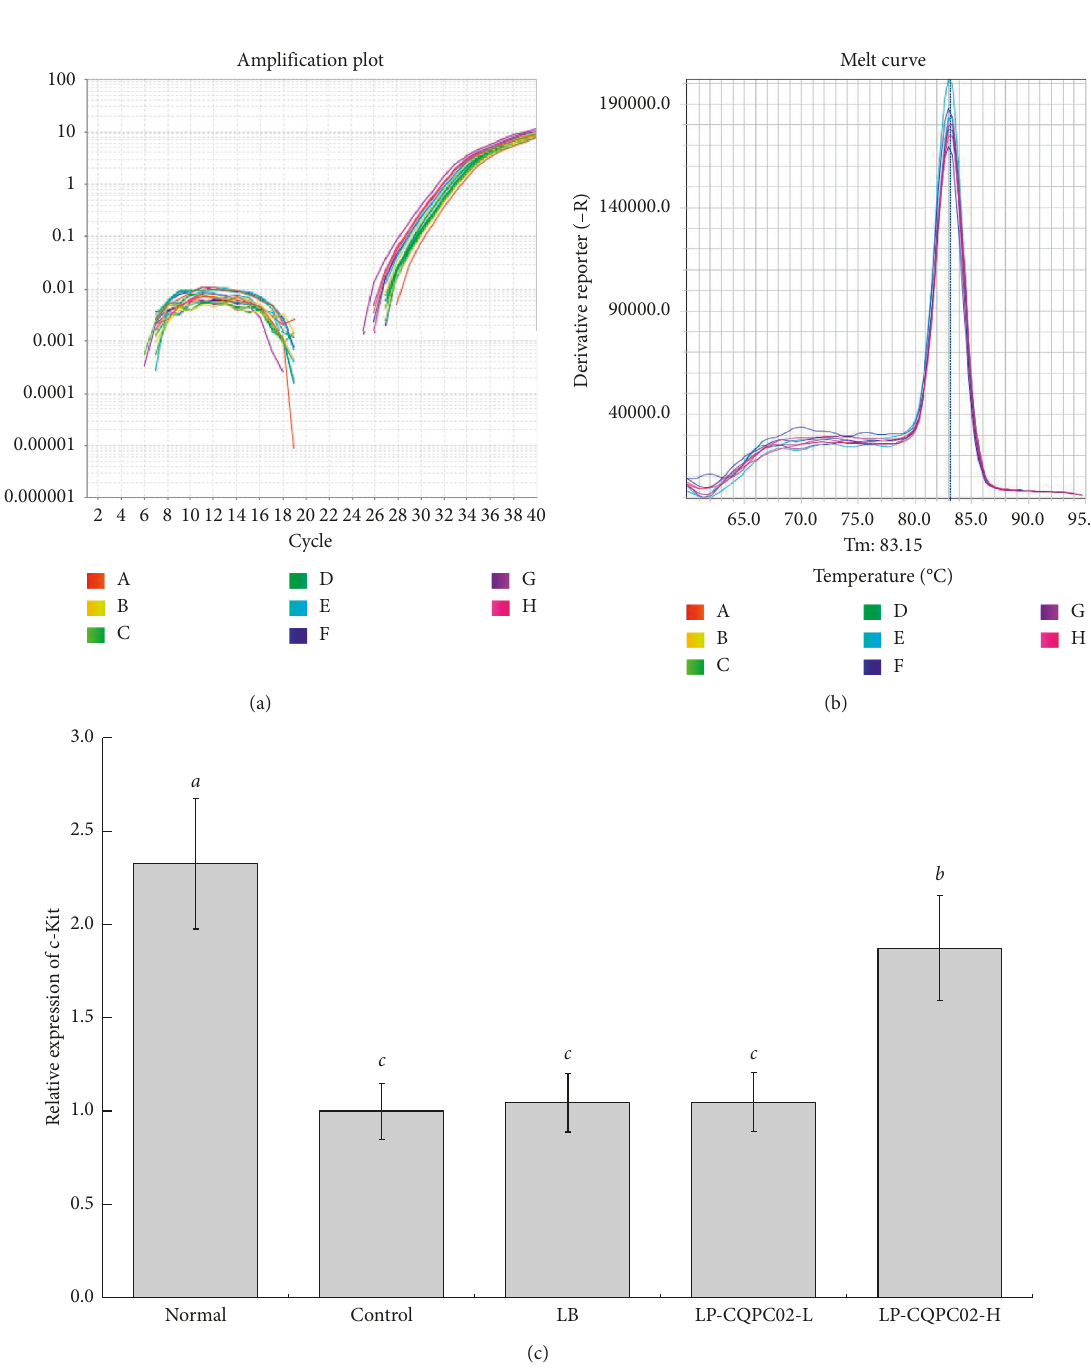
Figure 4: The mRNA expression level of c-Kit in the small intestine tissue of mice. (a) Amplification curve, (b) dissolution curve, and (c) relative expression. Values presented are the mean ± standard deviation. a–c The mean values with different letters in the same bars are significantly different ( p < 0.05) according to Duncan’s multiple-range test; there was no significant difference in the same letter repre- sentation between the two bars ( p > 0.05), but there was significant difference in the different letter representation ( p < 0.05). LB: Lactobacillus delbrueckii subsp. bulgaricus (1.0 × 10 9 CFU/kg b.w. gavage); LP-CQPC02-L: Lactobacillus plantarum CQPC02 (1.0 × 10 8 CFU/kg b.w. gavage); and LP-CQPC02-H: Lactobacillus plantarum CQPC02 (1.0 × 10 9 CFU/kg b.w. 3.10. iNOS mRNA Expression in the Small Intestine of Mice. significantly ( p < 0 . 05) lower than that of the other groups (Figure 8). The expression of iNOS in the small intestine of LP-CQPC02-H, LP-CQPC02-L, and LB mice increased in turn. The expression of iNOS in the small intestine of LP- CQPC02-H mice was the closest to that of the normal mice.